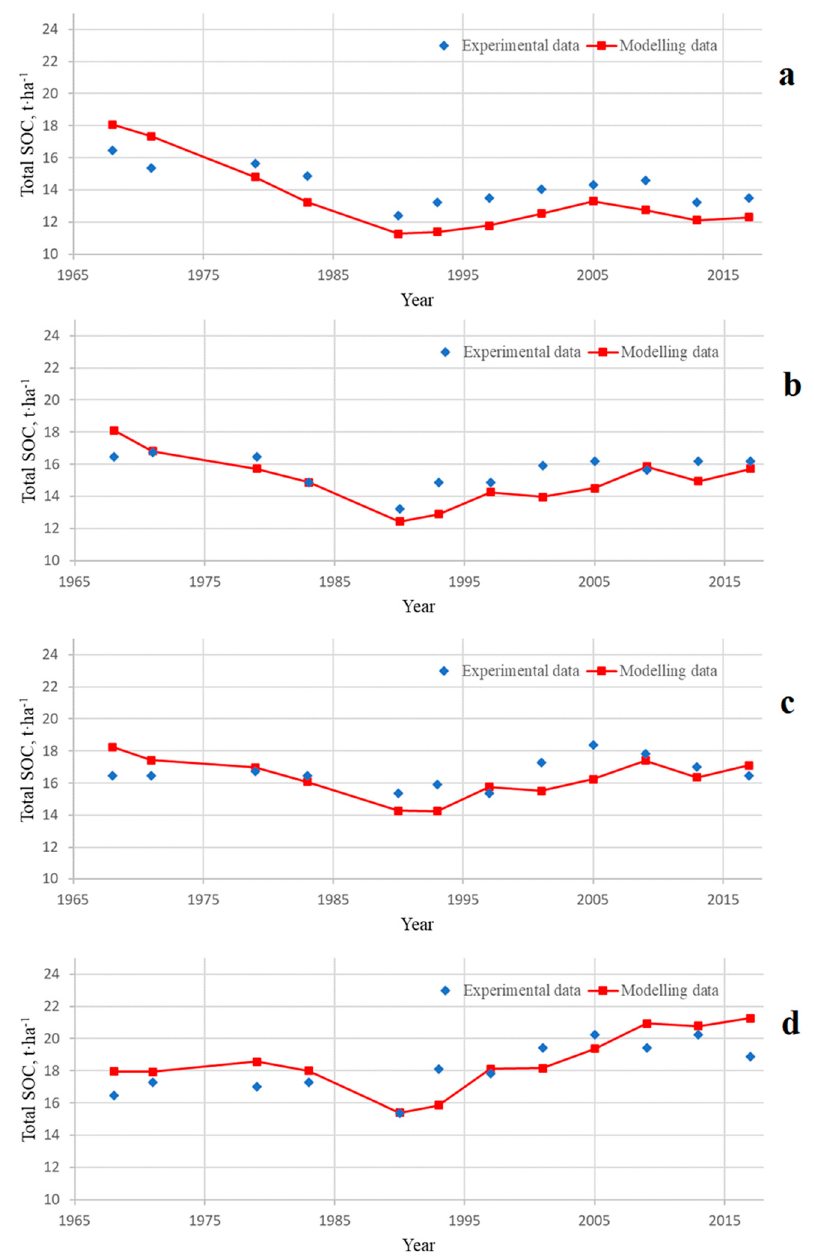
Figure 4. Experimentally determined (dots) and calculated (lines) by RothC SOC stocks in a 0–20 cm soil layer of a long-term experiment in the period 1968–2017 for four treatments: ( a )—control, ( b )—NPK, ( c )—1/2FYM + 1/2NPK, ( d )—FYM + 2NPK.